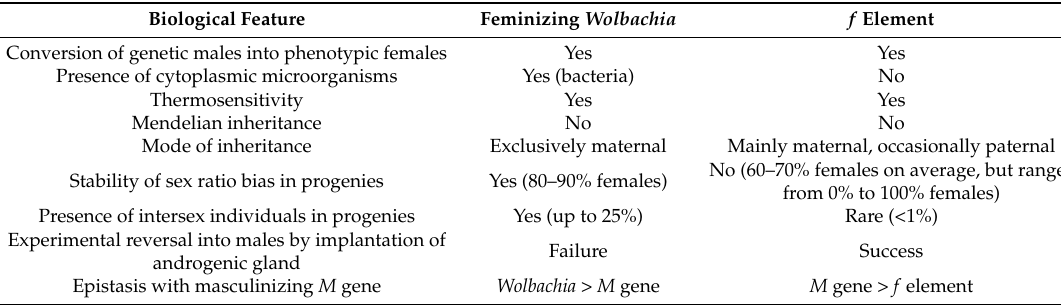
Table 1. Comparison of various biological features of feminizing Wolbachia and the f element in the terrestrial isopod Armadillidium vulgare